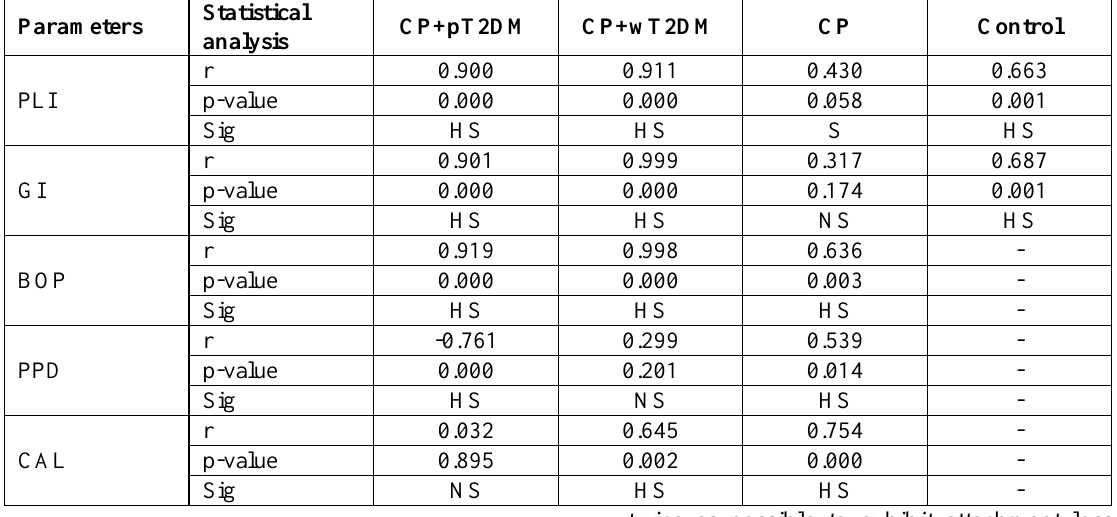
Table 5: Correlations between the levels of osteocalcin with the clinical parameters of each study and control groups